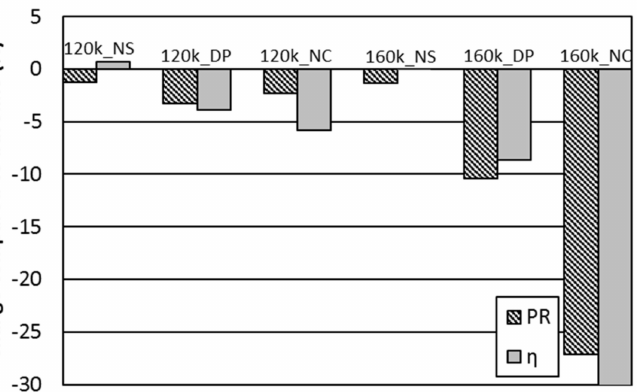
Figure 16. Comparison between baseline and “Unbladed” fan test data to illustrate the influence of inlet section geometry on stage